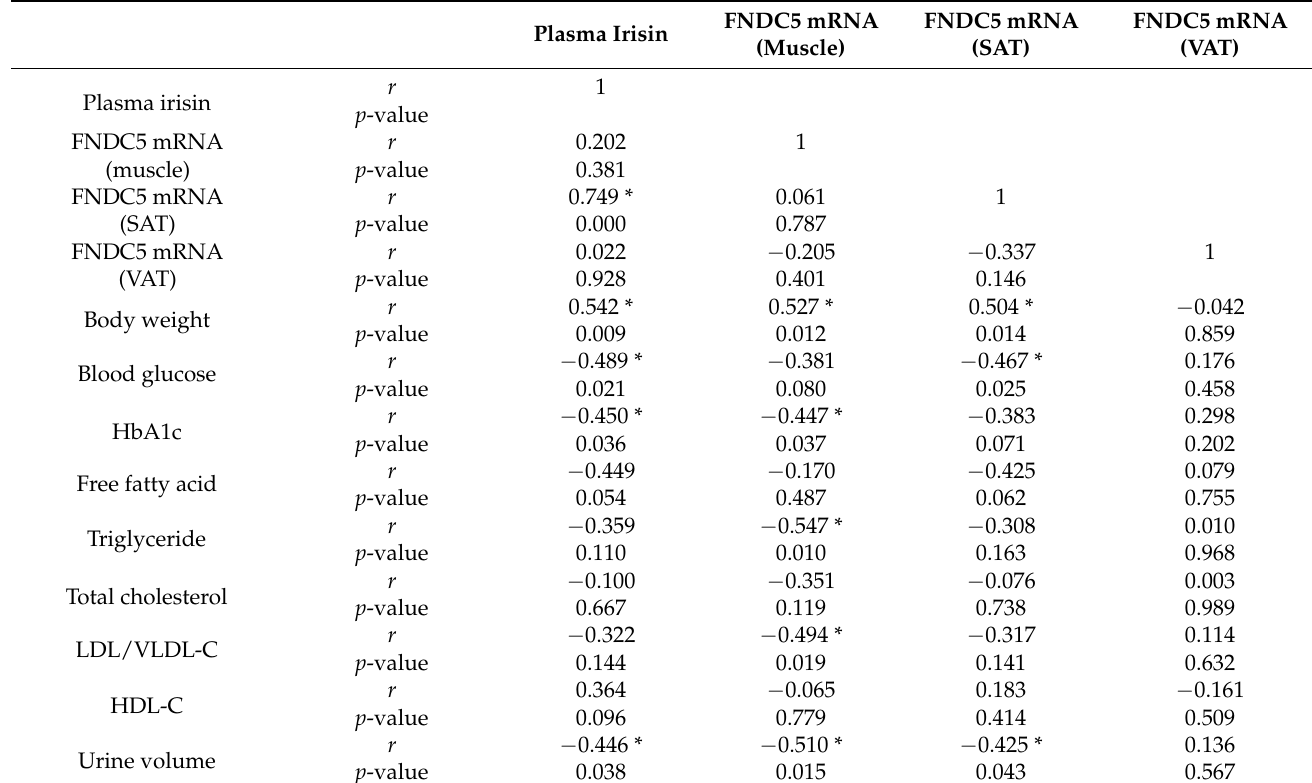
Table 2. Correlation between plasma irisin, FNDC5 mRNA, and metabolic parameters in streptozotocin-induced diabetic mice.